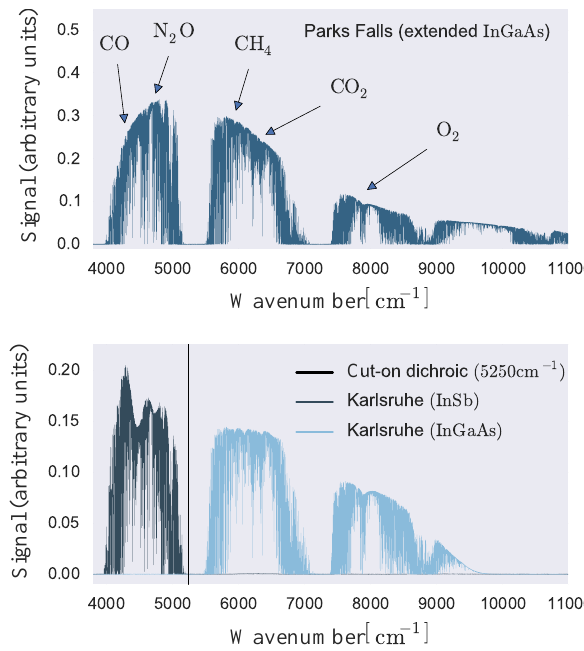
Figure 1. Upper panel: typical TCCON spectrum recorded by the Park Falls instrument which operates an extended InGaAs detec- tor, marked are the spectral regions of the main gases of interest; lower panel: typical Karlsruhe spectrum recorded by the InSb and InGaAs diode. The coverage of the full spectral range from 3800– 10000cm − 1 is realized by the simultaneous operation of the two